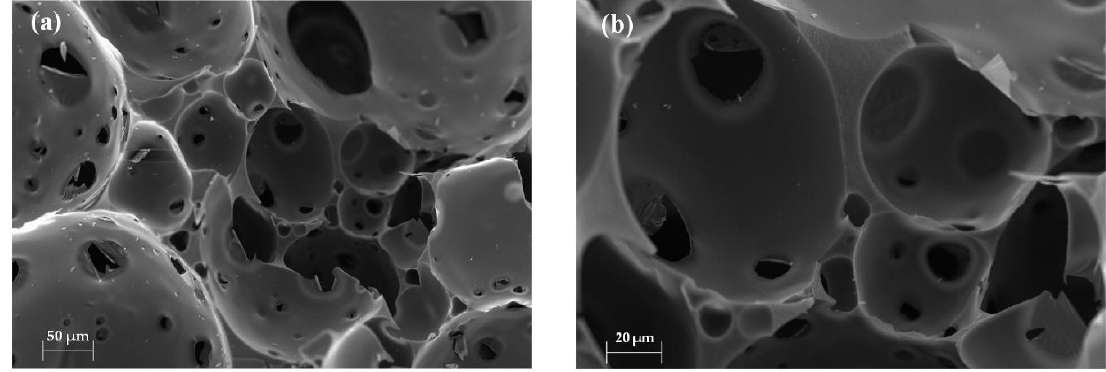
Figure 5. SEM images of carbon foam with low ( a ) and high magnification ( b ) [146]. Other advanced electrodes that improve the O 2 -supply are gas diffusion electrodes (GDE) evaluated by different researchers. Zarei et al. [150] synthesized a three-dimensional graphene (3DG)-based carbon paper GDE for the removal of nalidixic acid. The nalidixic acid removal was 90%, which was attributed to a higher surface area with more irregulari- ties and roughness than graphene oxide, allowing rapid diffusion of O 2 to achieve higher H 2 O 2 production. On the other hand, Zhou et al. [151] used graphite felt, but in this case, as a floating cathode in which one side of a porous cathode is open to the air, and the other side is submerged in the aqueous solution instead of the traditionally submerged